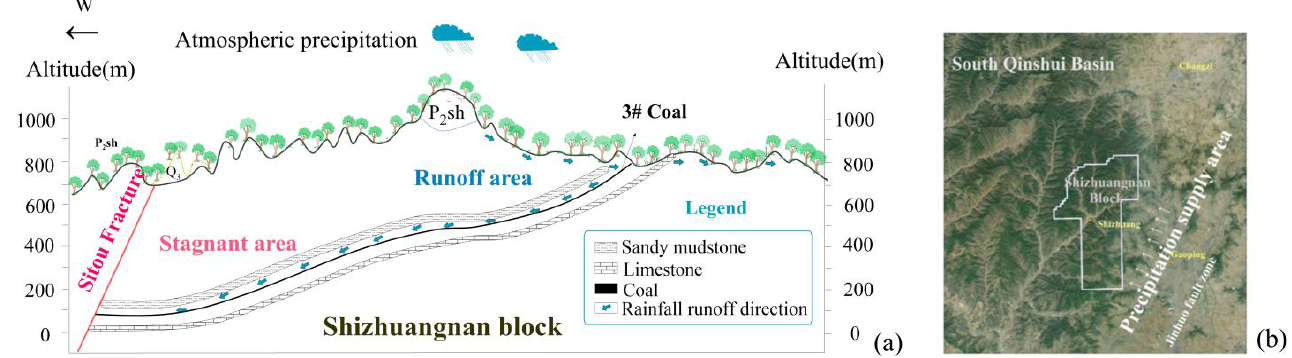
Figure 2. ( a ) Distribution of #3 coal seam reservoir and seepage of atmospheric precipitation in the study area; ( b ) satellite topographic map of the study